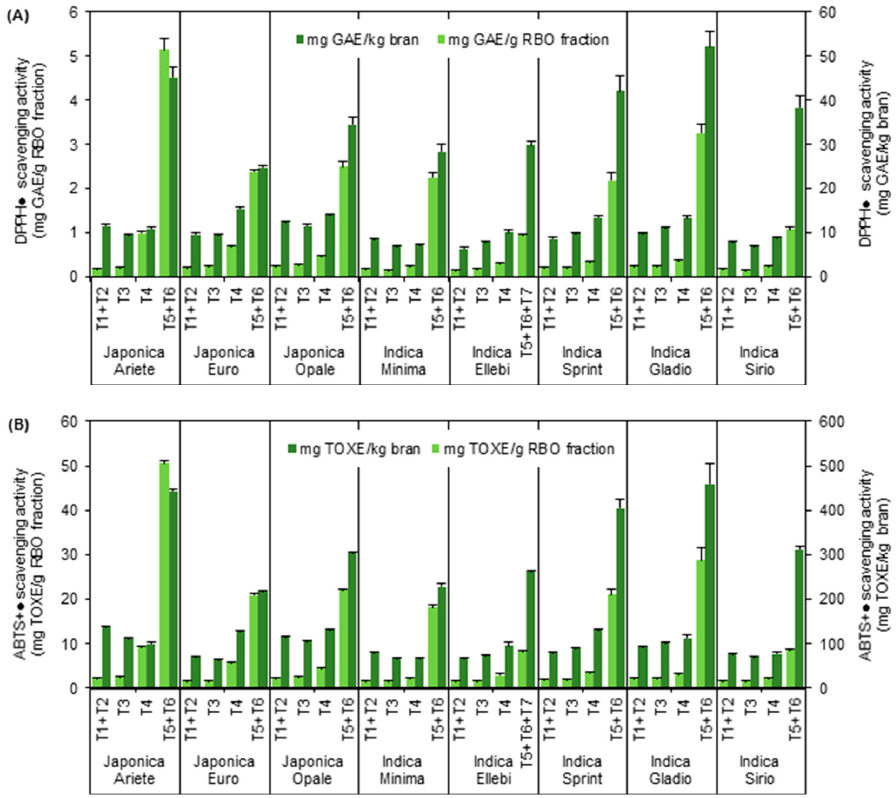
Figure 7. Antioxidant activity of Hex-RBO fractions: ( A ) DPPH radical scavenging and ( B ) ABTS radical cation scavenging activity.